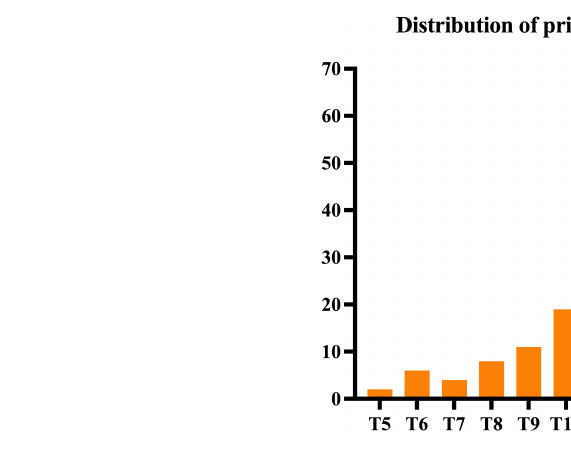
FIGURE 1 Distribution of primary vertebral